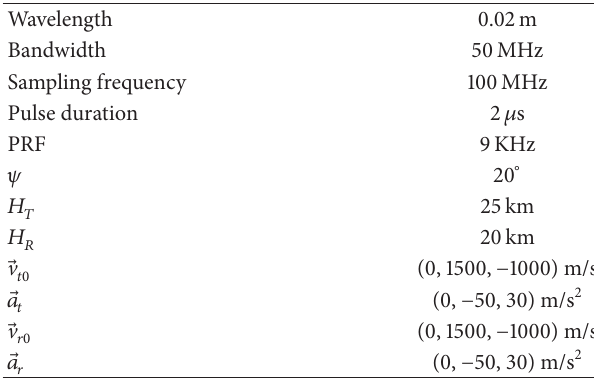
Table 1: Parameters used in the